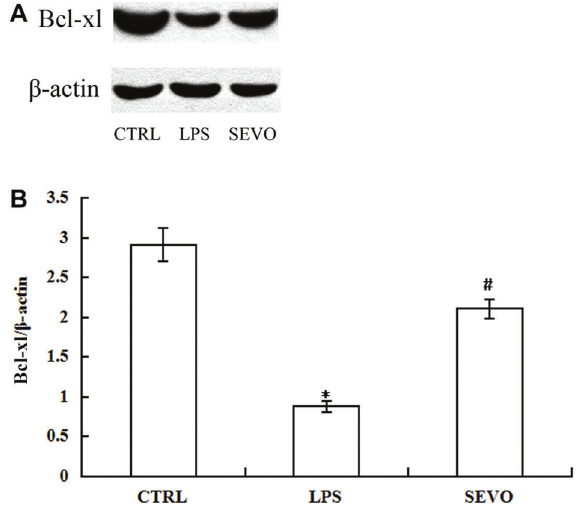
Figure 8. A , Western blot for Bcl-xl in lung tissue samples. B , Relative expression of Bcl-xl. CTRL: control group injected intratracheally with normal saline; LPS: injected intratracheally with lipopolysaccharide; SEVO: injected with LPS plus inhaled sevo fl urane for 30 min. Data are reported as means ± SD (n=6 per group). *P o 0.01 vs CTRL; # P o 0.01 vs LPS (ANOVA).